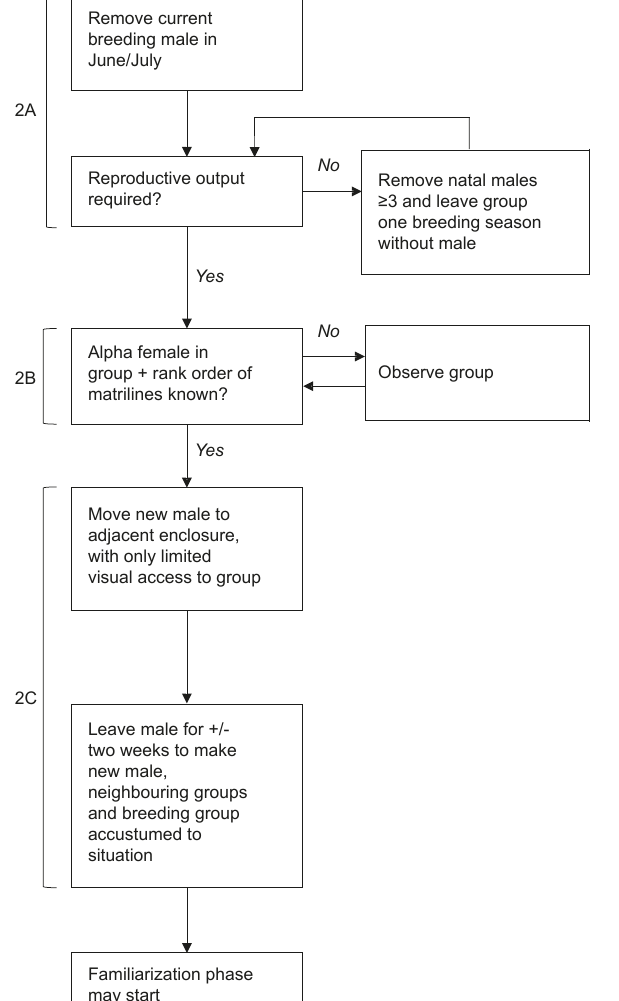
Figure 3. Step 2: The stepwise preparation of a male introduction, concerning the removal of the previous breeding male and sub-adult natal males (2A), observing the group (2B), and moving the new male